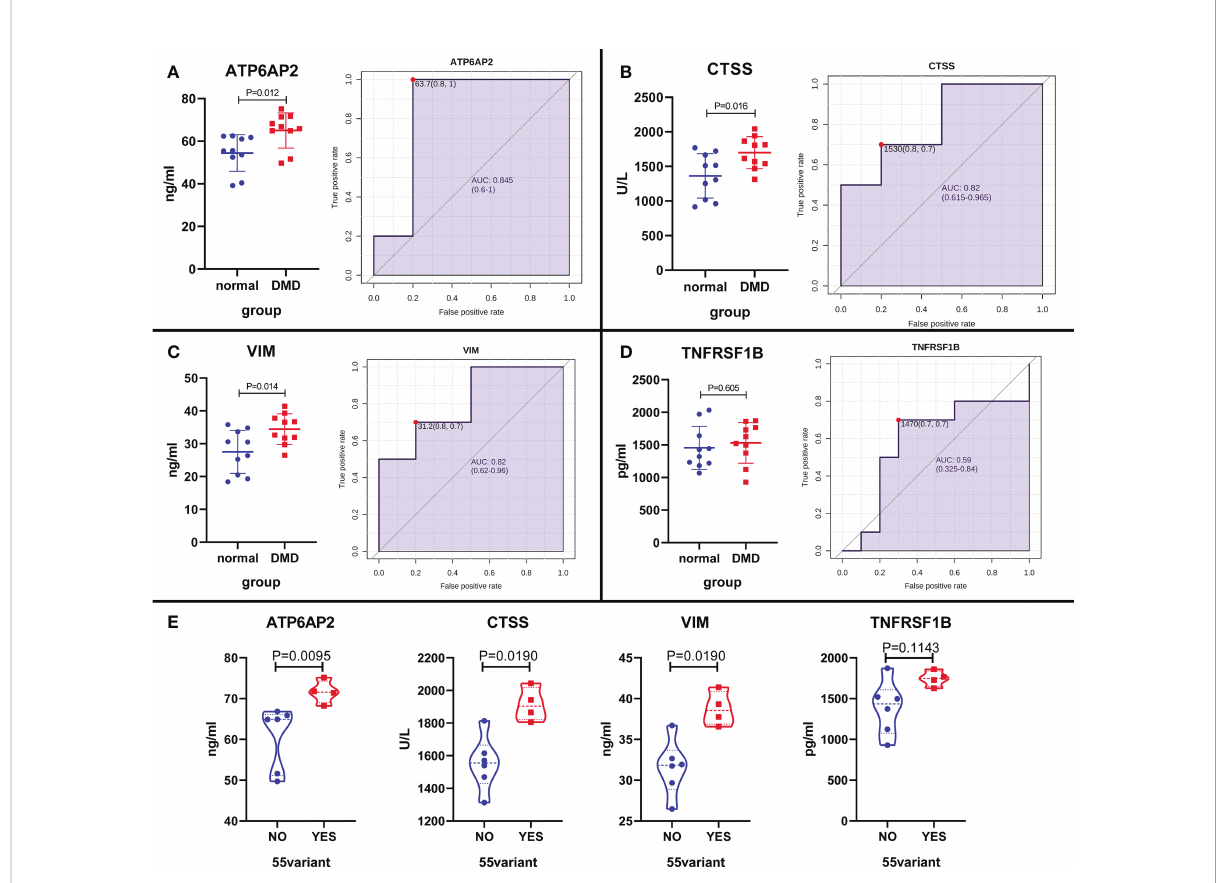
FIGURE 12 The expression level validation of the four proteins in DMD patients and healthy controls using ELISA. (A – D) A boxplot and ROC curve evaluation of the diagnostic effectiveness of the 4 proteins in 10 DMD patients and 10 healthy controls. (E) A boxplot evaluation of the diagnostic effectiveness of the 4 proteins in DMD patients with and without exon 55